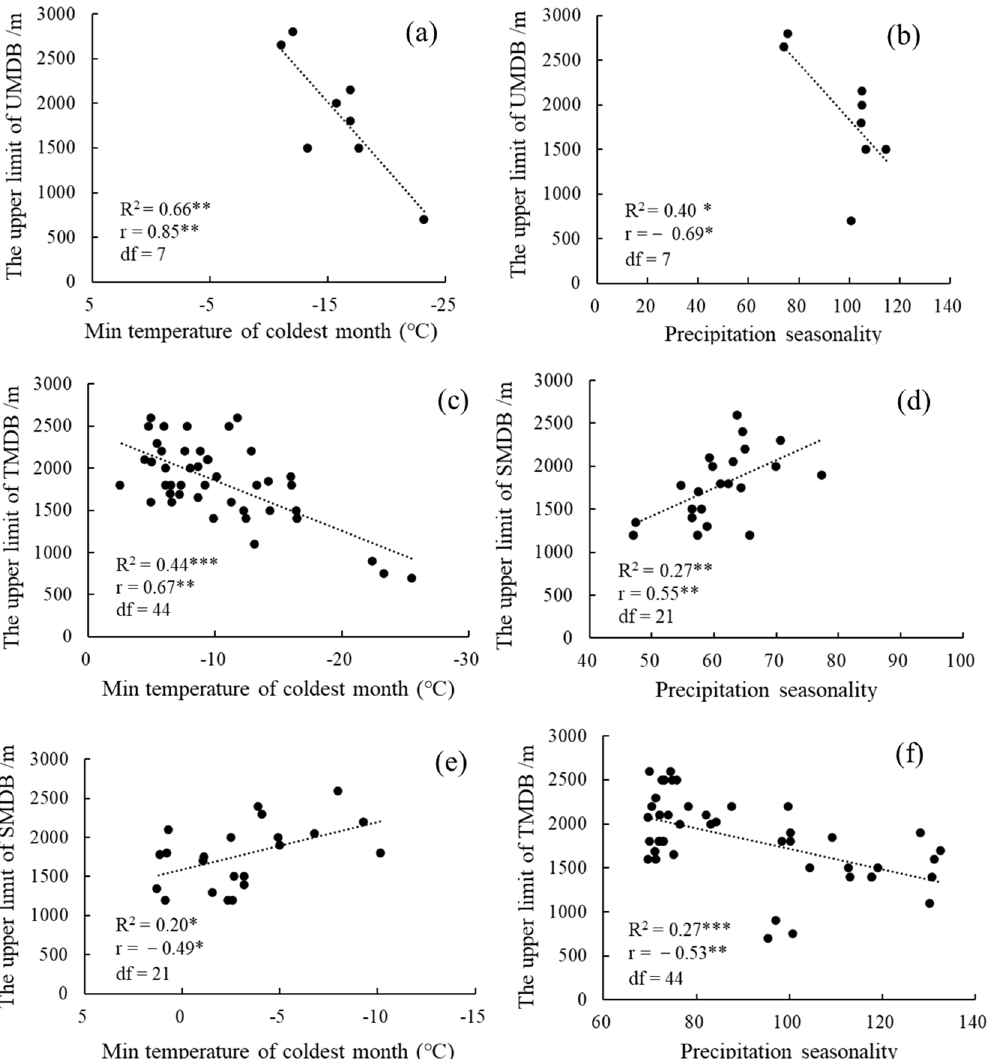
Figure 5. The effect of climate on the upper limit of deciduous broad-leaved forest on the mountains with climatic treeline ( a , b ) or without climatic treeline ( c – f ). “r value” represents Pearson correlation coefficient. MDB, deciduous broad-leaved forests on the mountains with climatic treeline; UMDB, deciduous broad-leaved forests on the mountains with climatic treeline; TMDB, deciduous broad-leaved forests on the temperate mountains without climatic treeline; SMDB, deciduous broad-leaved forest on the subtropical mountains without climatic treeline. “r value” represents Pearson correlation coefficient. df, degree of freedom. Note: * p < 0.05, ** p <0.01, *** p < 0.001.